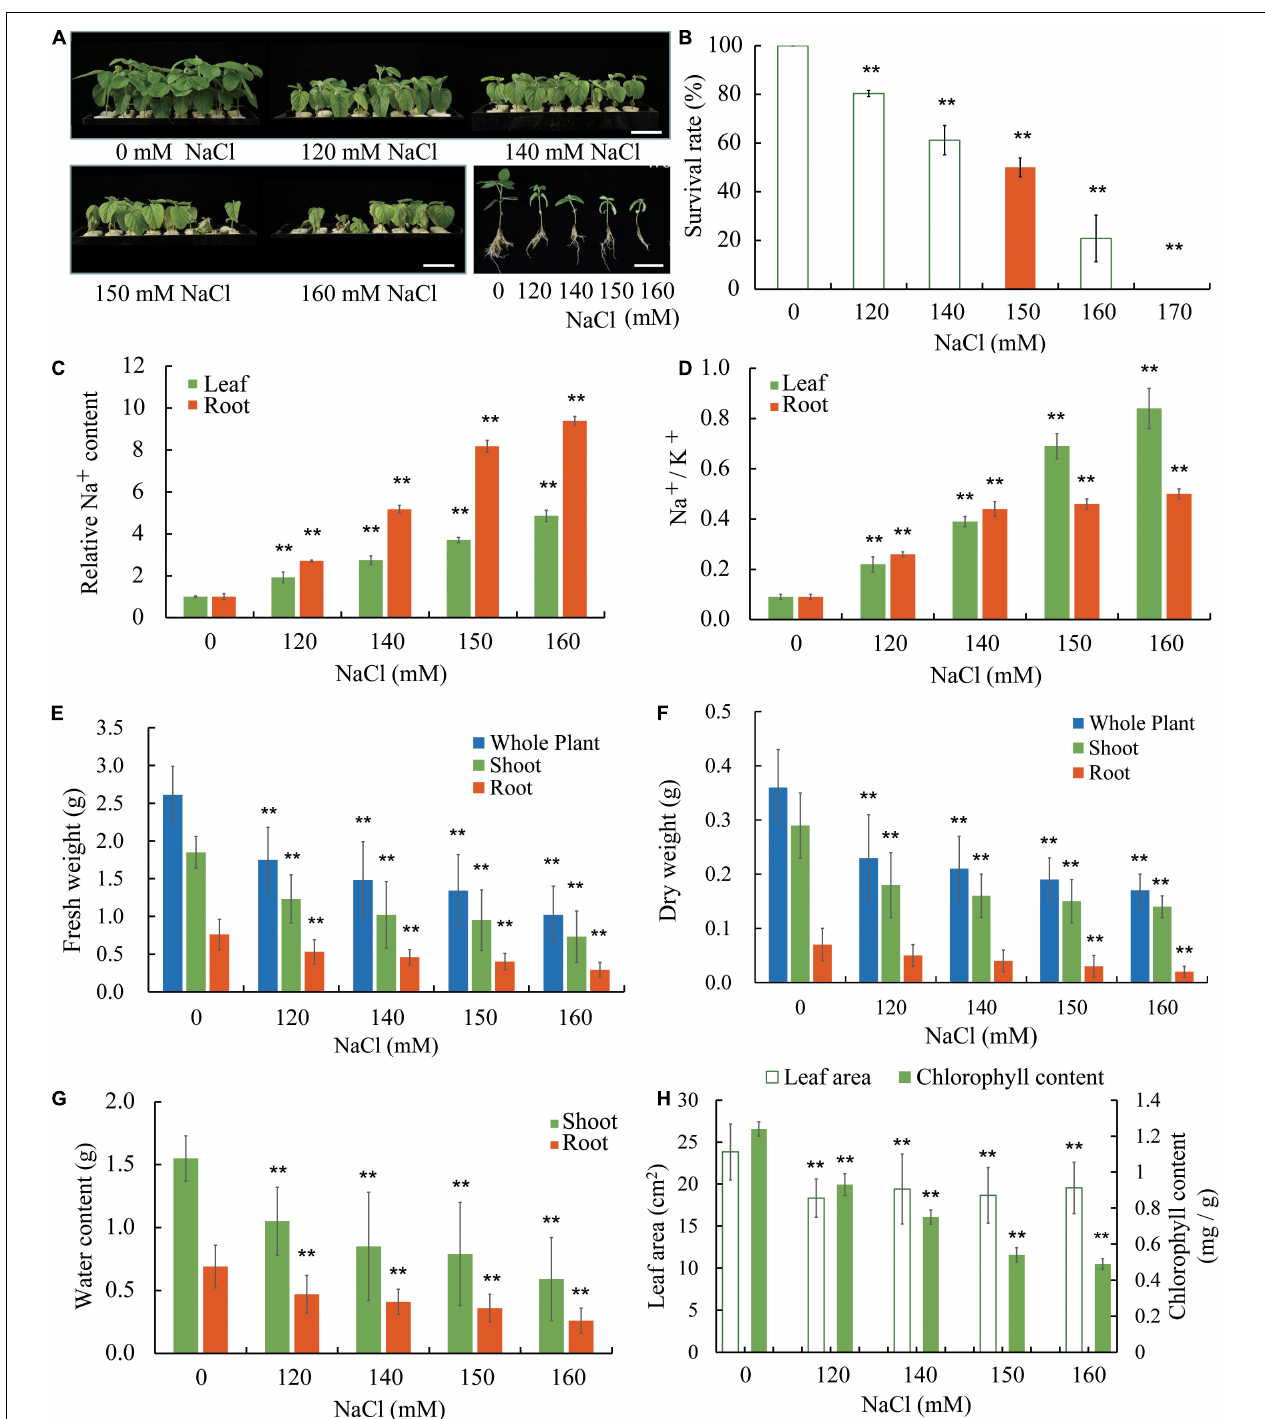
FIGURE 1 | Salt sensitivity of Williams 82 (W82) plants. (A) Growth of seedlings in liquid growth medium containing 0, 120, 140, 150, or 160 mM NaCl. Bar = 6 cm. (B) The survival rates of plants as shown in (A) and data for plants treated with 170 mM NaCl are also provided. Survival is defined as the ability of shoot apical meristem to initiate new trifoliate leaves after the salt stress treatment. (C) The relative Na + content in roots and unifoliate leaves of plants as shown in (A) . (D) The Na + /K + ratios in roots and unifoliate leaves from plants as shown in (A) . (E) The fresh weight of whole plants, shoots, and roots of plants as shown in (A) . (F) The dry weight of whole plants, shoots, and roots of plants as shown in (A) . (G) The relative water content of shoots and roots of plants as shown in (A) . (H) The chlorophyll content and the area unifoliate leaves of plants as shown in (A) . The data are means ± SD [ n = 3 (there are at least 12 plants in each biological replicate)]. Significant differences in mean values relative to the mean value of unstressed plants are indicated by Student’s t -tests (** p < 0.01).